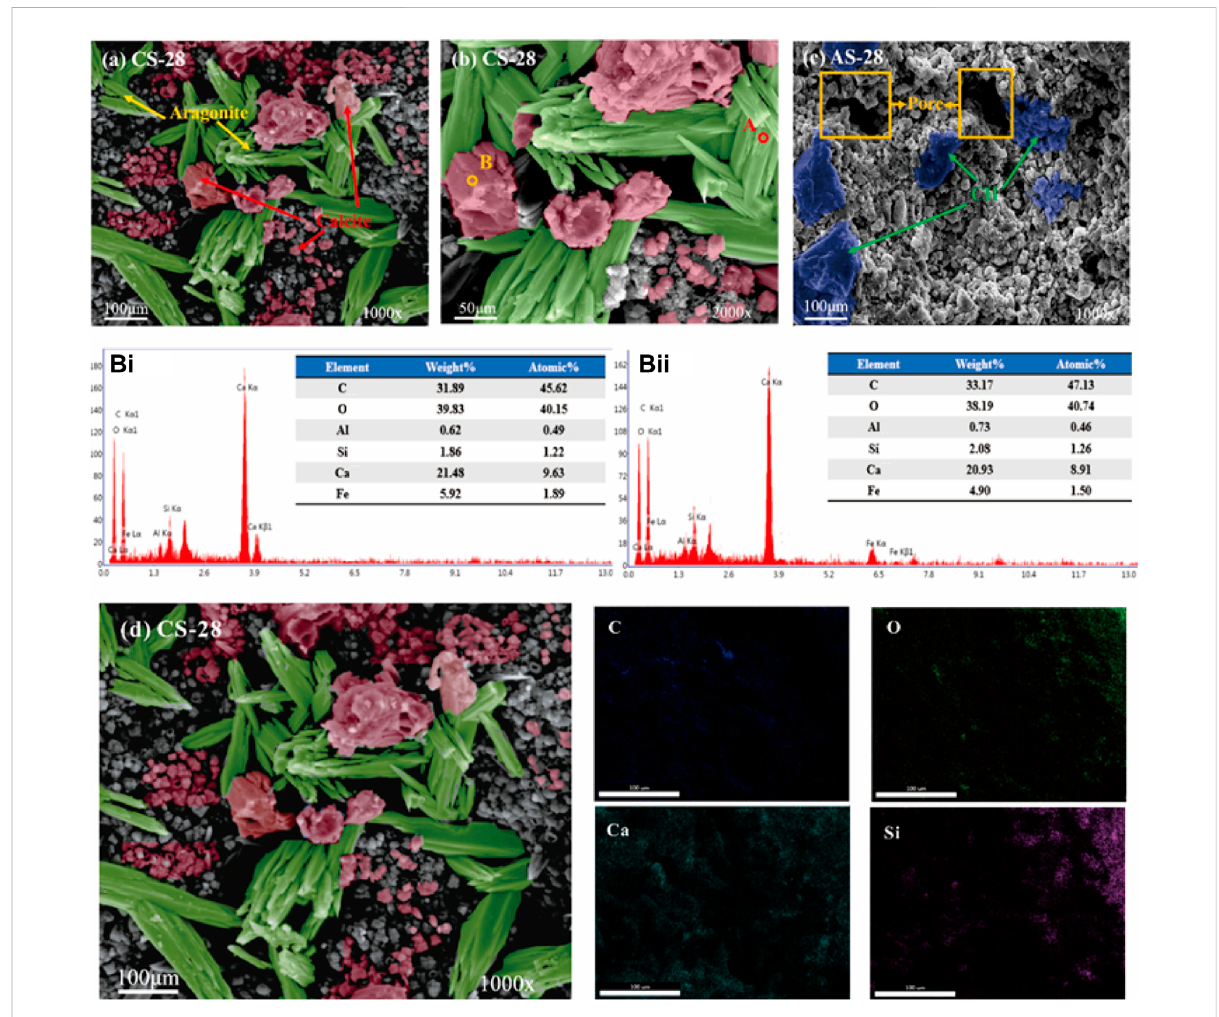
FIGURE 3 ESEM photographs of the self-healing products on the crack surface of the sample and crack surface: (A) CS-28 sample; (B) CS-28 sample material magni fi ed 2000 times; (C) AS-28 sample; (Bi) EDX spectrum of point A in (B) ; (Bii) EDX spectrum of point B in (B) ; (D) elemental maps (C,O, Ca, and Si) of the cracked surface of the CS-28